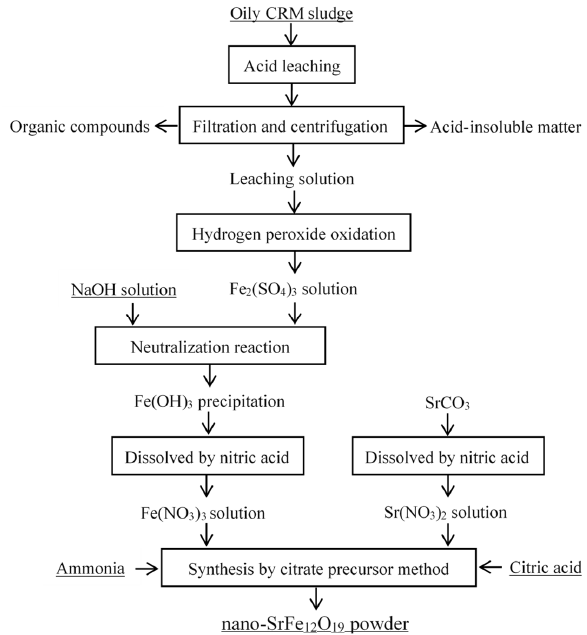
Figure 1. The process flow chart of SrFe 12 O 19 powder obtained from oily CRM sludge.